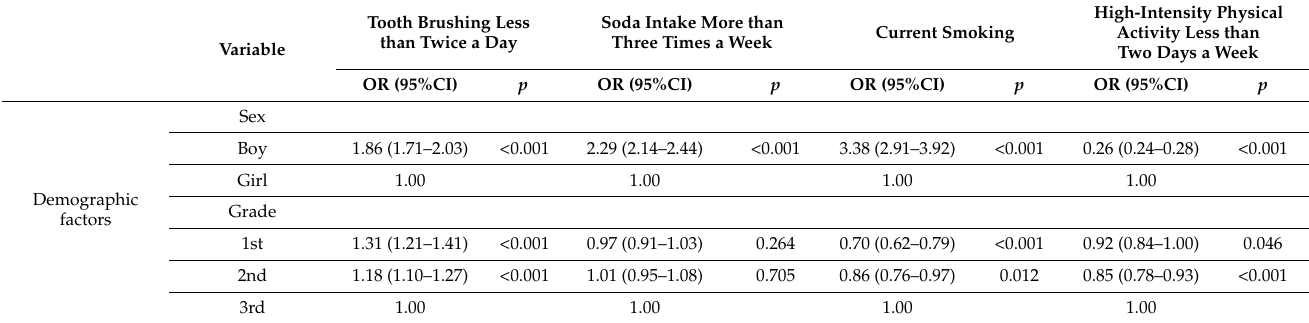
Table 2. Individual-level factors affecting students’ health